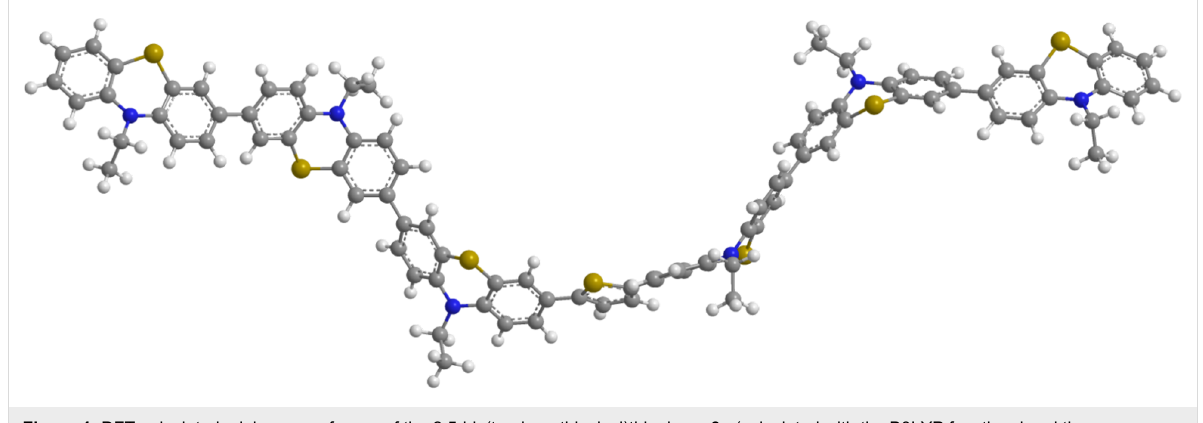
Figure 4: DFT-calculated minimum conformer of the 2,5-bis(terphenothiazinyl)thiophene 3c (calculated with the B3LYP functional and the 6-311G(d,p) basis set).